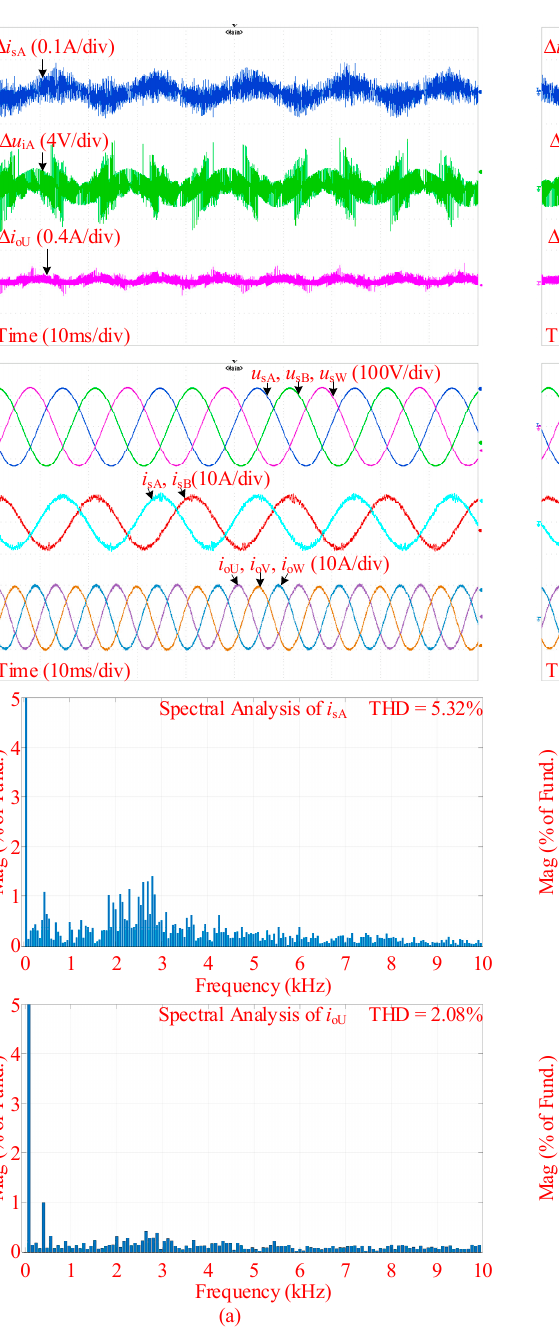
Figure 8. Experimental results of Case 3: ( a ) with the conventional MPC and ( b ) with the improved MPC. Parameters of the prediction models are inaccurate.